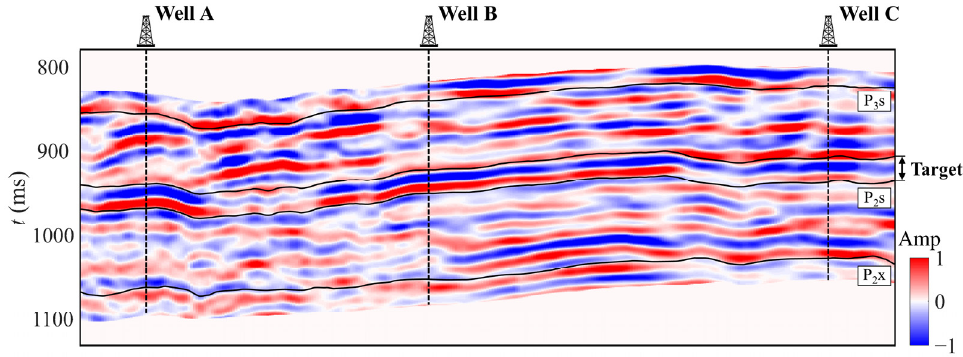
Figure 5. The seismic section across wells A, B, and C.